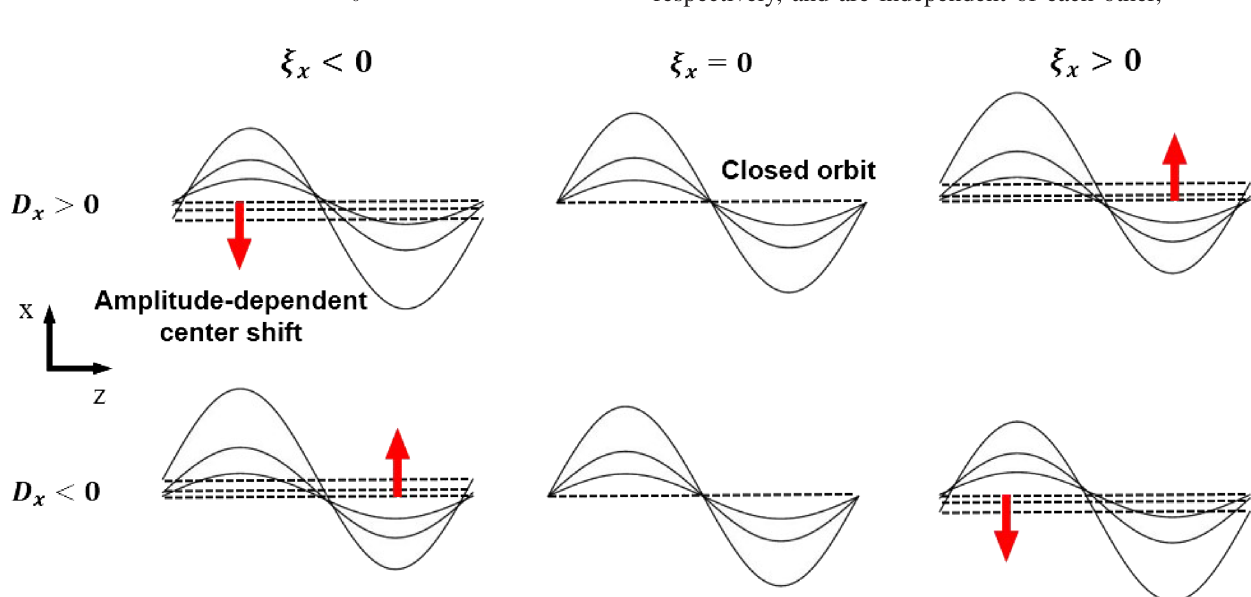
FIG. 8. Physical pictures of the amplitude-dependent shift of betatron oscillation center in the case of a positive momentum compaction. Only a horizontal betatron oscillation is considered in this